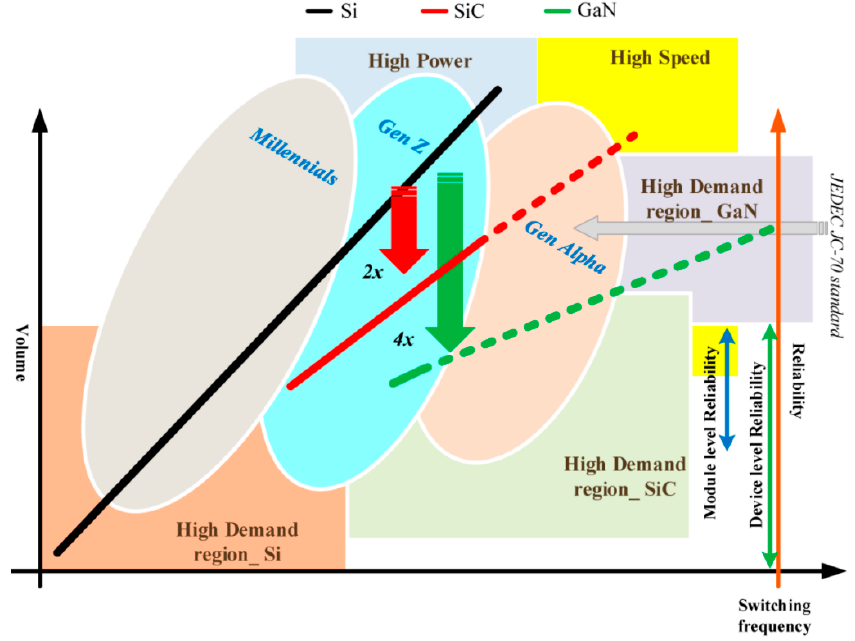
Figure 2. Power density increment by high switching frequency operations [20].